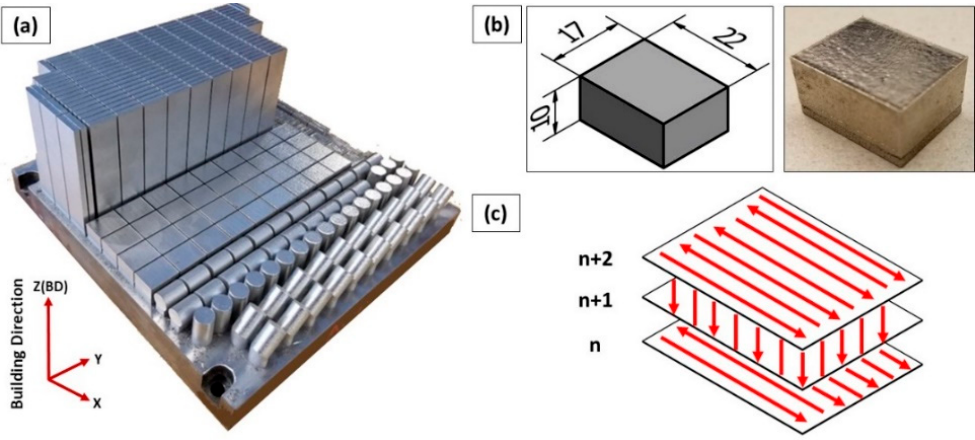
Figure 2. ( a ) LPBF building platform of IN718 displaying the building orientation; ( b ) schematic drawing and real as-printed IN718 test samples after WEDM removal; ( c ) schematic illustration of the laser scanning strategy in this study.